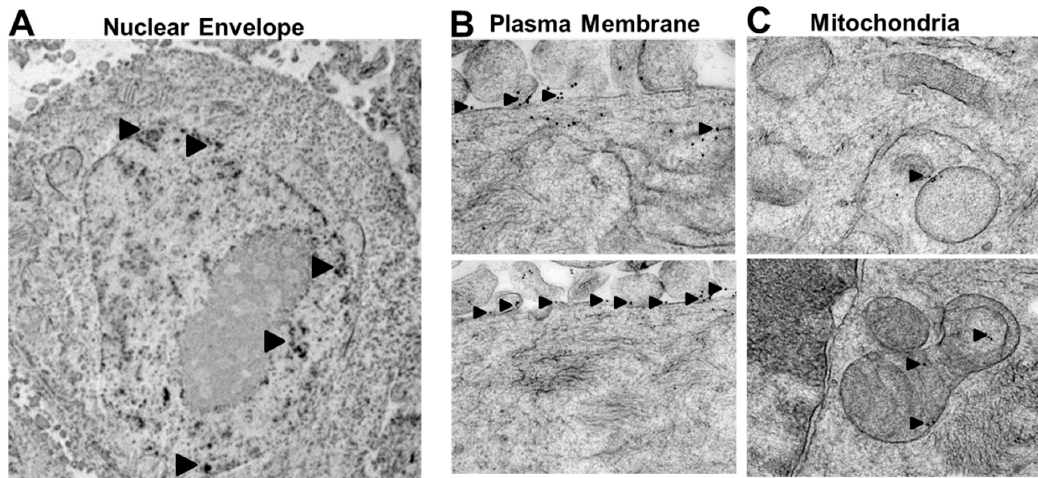
Figure 1. Subcellular localization of Rlip imaged by electron microscopy. Immunogold EM on MCF7 cells was performed as described in the Materials and Methods. Electron microscopy was done on a FEI Tecnai 12 transmission electron microscope equipped with a CCD camera. Black arrow heads point to staining of ( A ) nuclear membrane as well as of the ( B ) plasma membrane and ( C ) mitochondria. Magnification of the image: 11,000×.